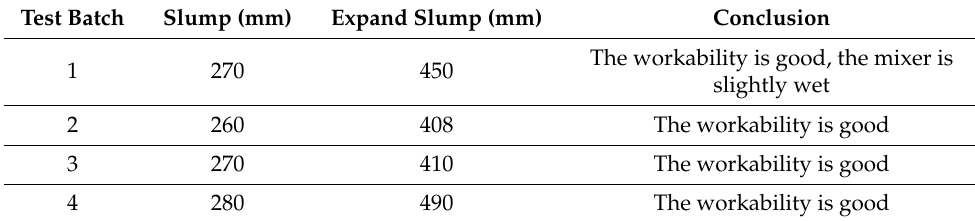
Table 2. Slump test results for RPC.